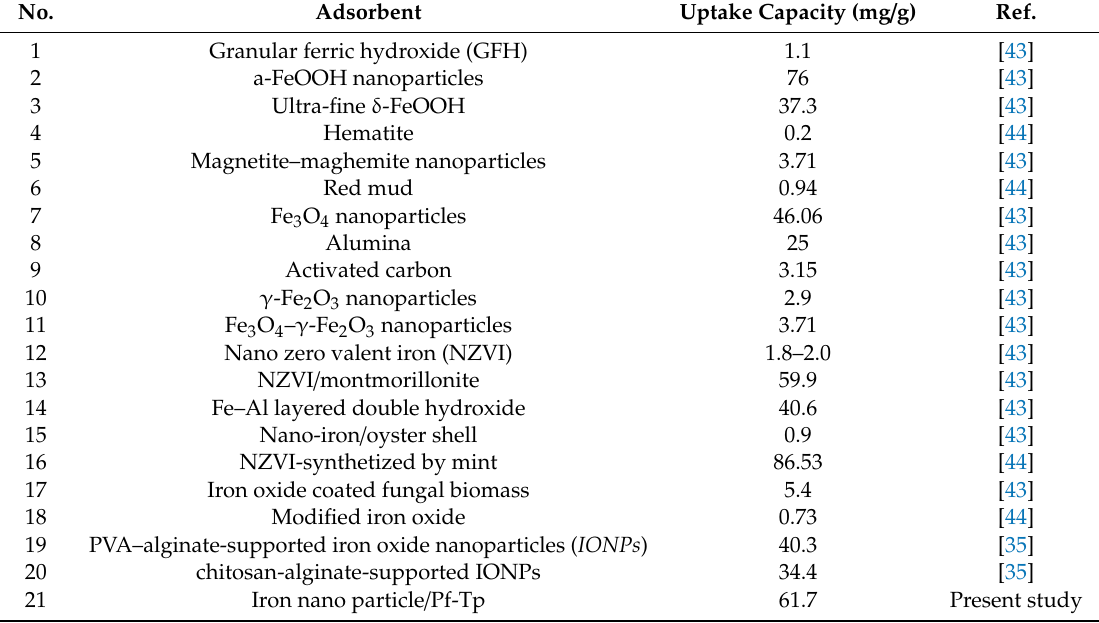
Table 8. The comparison of arsenic sorption capacity for di ff erent